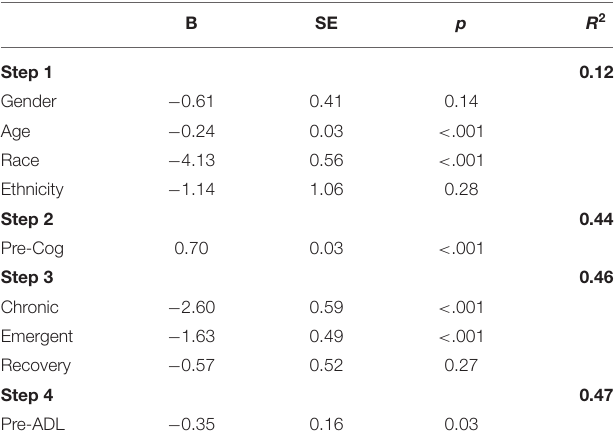
TABLE 2 | Hierarchical linear regression predicting post-stroke